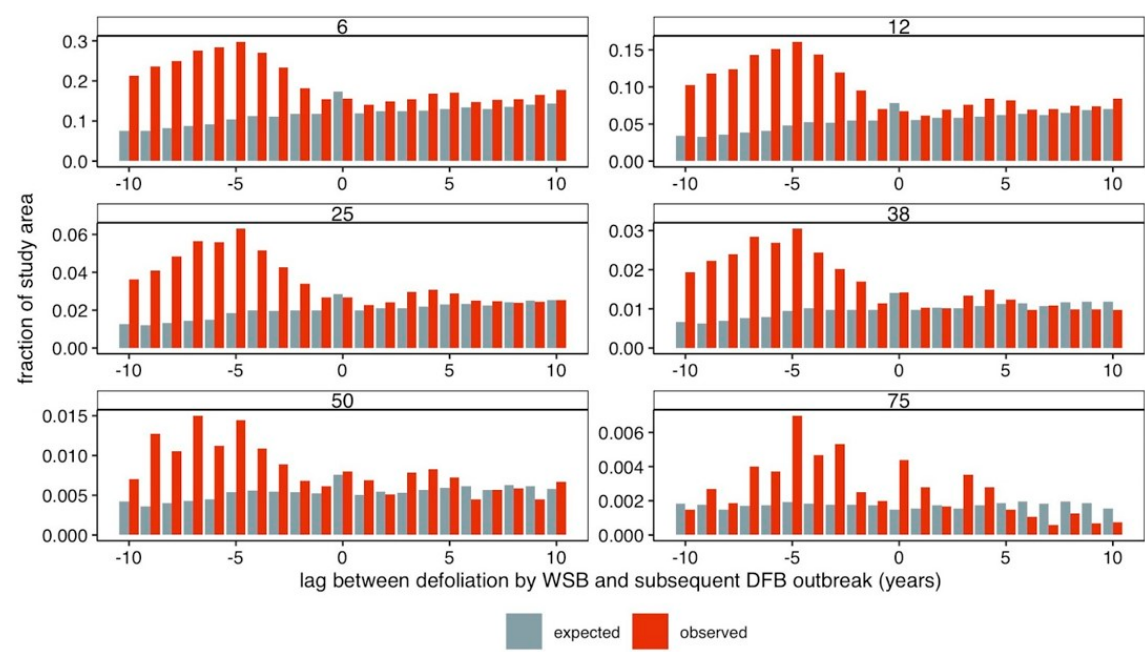
Figure A1. The observed and expected proportion of pixels affected by DFB and WSB by temporal lag for several thresholds (6%, 12%, 38%, 25%, 50%, 75%; panels) of percent area used to define the presence of DFB, WSB, and Douglas-fir. Here, − 5 signifies that WSB defoliation occurred 5 years prior to DFB presence. Note that y-axes span different ranges.